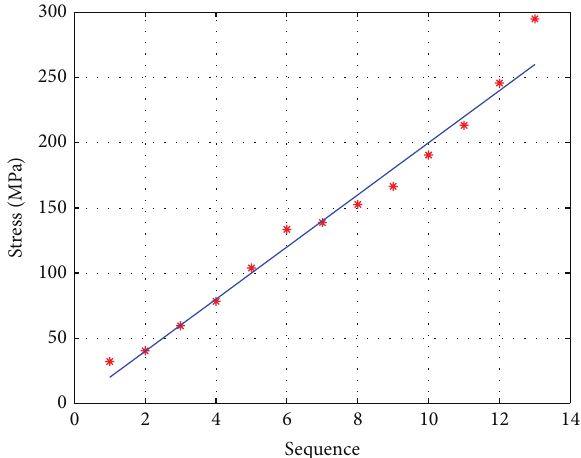
Figure 7: The comparison result of a 8.8 low-carbon steel bolt.